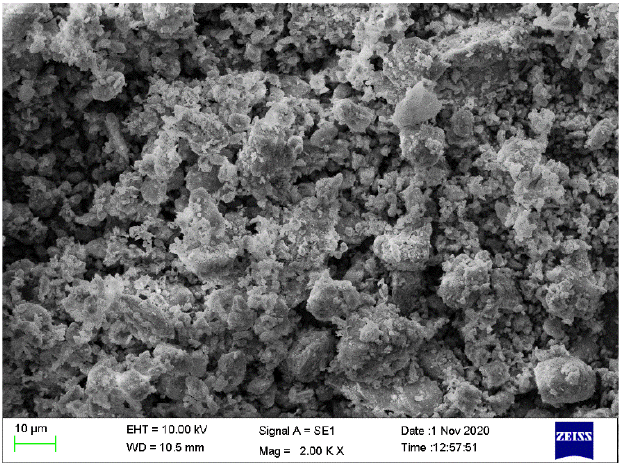
Figure 10. SEM image of the residue.